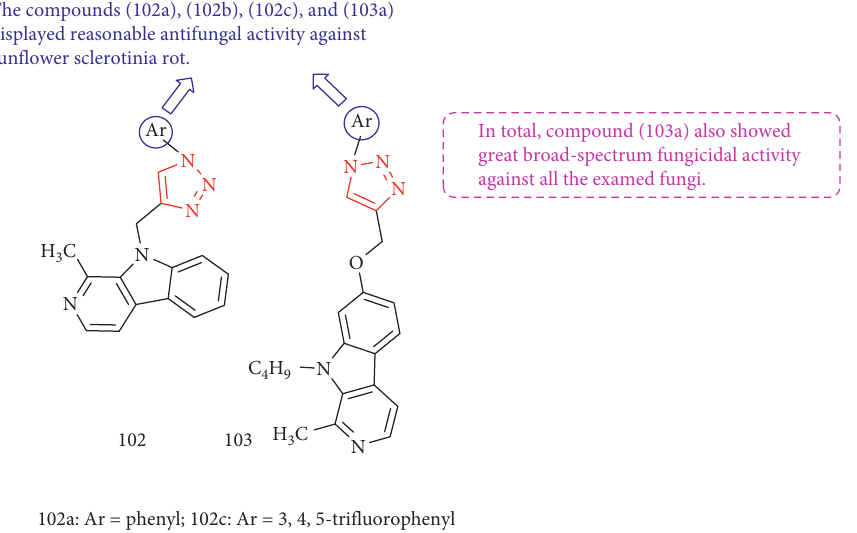
Figure 46: Chemical structure of two series of new aryl-1,2,3-triazole- β -carboline hybrids.